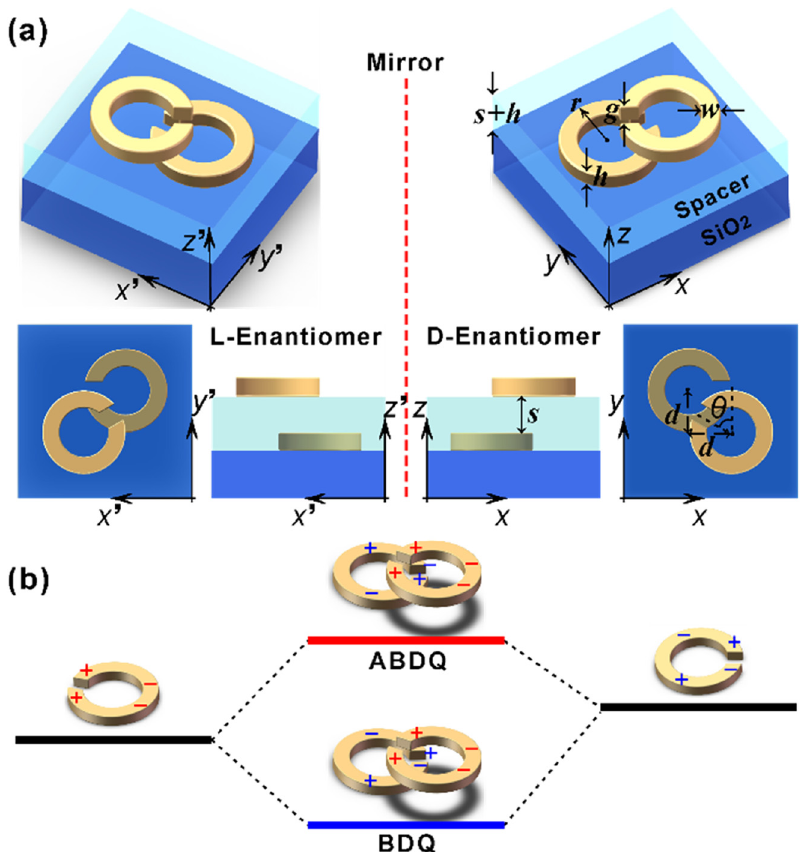
Figure 1: Geometric configuration and plasmon hybridization of a modified